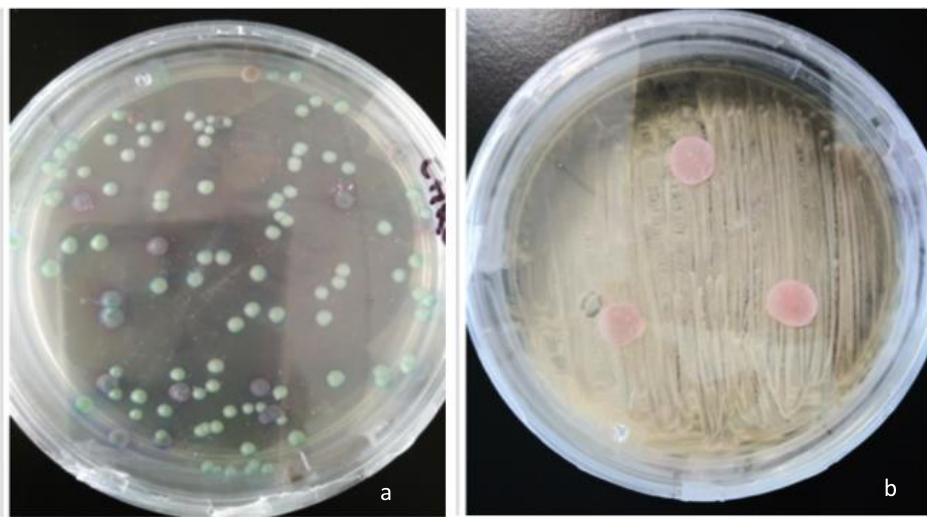
Figure 3. Example of a PMMA–AgNP composite application. ( a ) Culture obtained from a patient’s oral mucosa. The green colonies correspond to Candida albicans and the purple colonies correspond to Candida tropicalis cultured on CHROMagar Candida (CHROMagar, 4, Place du 18-Juin-1940, Paris, France, 75006). ( b ) PMMA–AgNP discs on cell culture plates. With this technique, we could not observe an inhibition zone because AgNPs could not be released from the PMMA discs. Silver nanoparticles embedded in the PMMA act as an agent that inhibits the growth of microorganisms on the surface of the discs. Author´s own images.